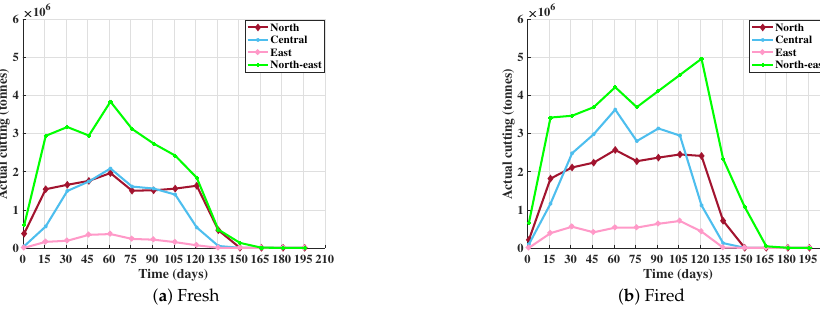
Figure 4. Actual cutting patterns for fresh and fired sugarcane for 2018/19.